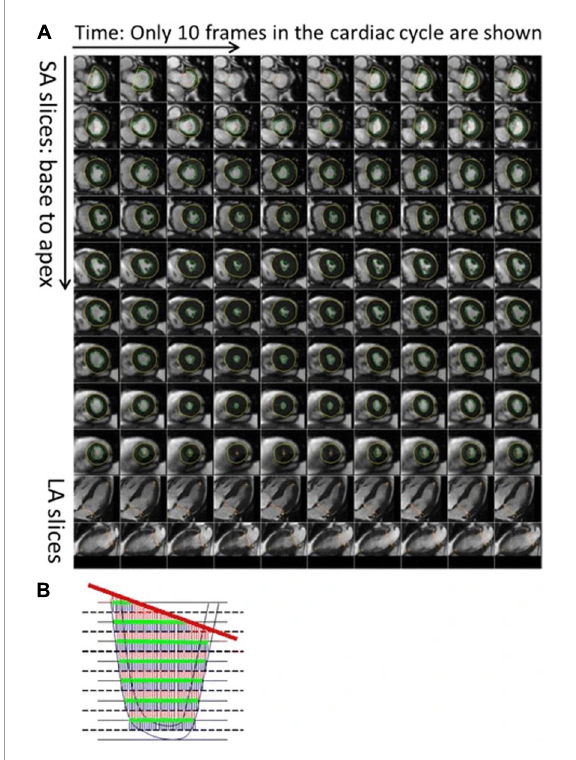
FIGURE1 Description of the automatic process to calculate left ventricular (LV) volume and strain. As shown, (A) the LV endocardium and epicardium are automatically contoured on the LV short axis slices. The mitral valve base plane is detected on the long axis slices of the left ventricle and projected onto the LV short axis slices. (B) To calculate the LV volumes, slices are stacked and contoured areas are summed up. At the same time, the mitral valve base plane is intersected with the stack of slices to remove portions of the volume that are above the base plane and inside the left atrium. From (38) with